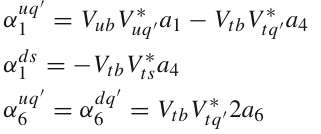
sponds to the three gluon propagators, which are drawn in Figs. 1a–c and 2a–c. Since V b μ and A b μ can be combined as the right-handed chiral current R μ = ( V b μ + A b μ )/ 2, and